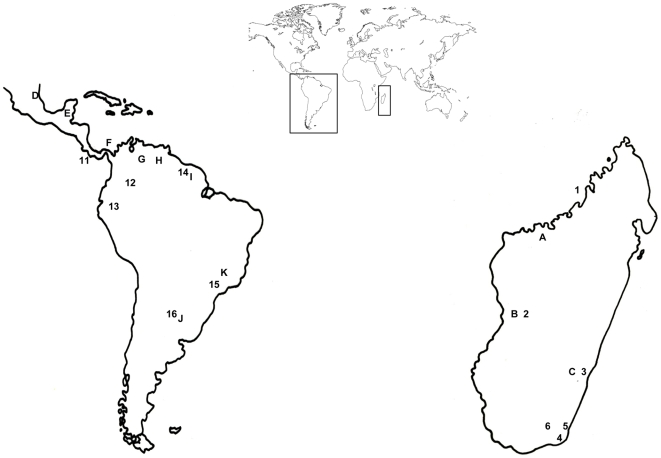
Sites for measures of fruit protein content (source of map: www.smithLifeScience.com/Tools.htm; free).Site labels are listed in Table 1. Letters refer to studies published previously. Numbers refer to new and yet unpublished studies.